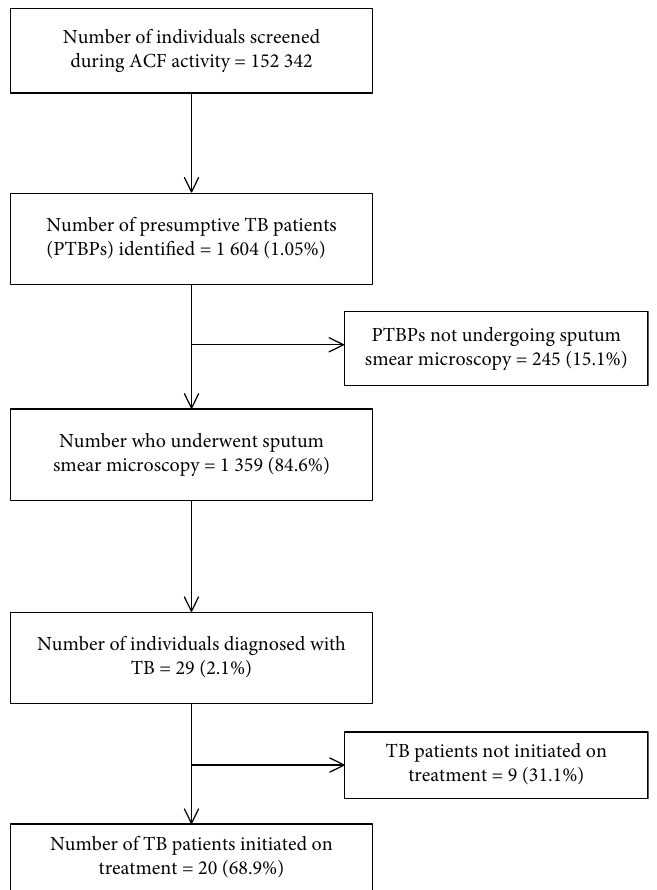
Figure 1: Number and percentage of participants at di ff erent stages of diagnostic and treatment cascade among presumptive TB patients identi fi ed by ACF activity in Bengaluru rural, Karnataka, India, during July